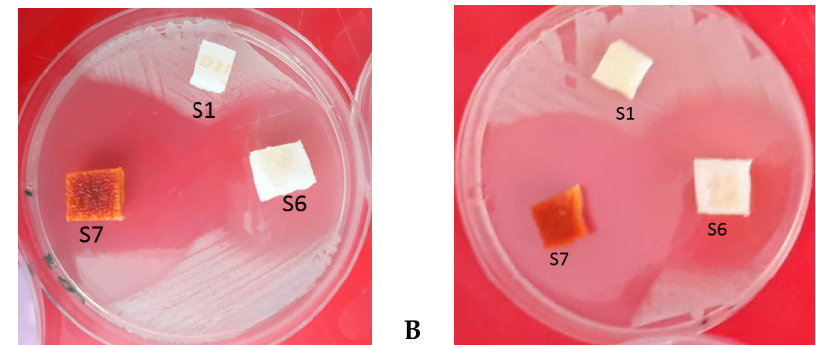
Figure 6. Exemplary photographs showing the antibacterial activity of the tested dressing: S6—modified Br 2 /Cip-Bi hydrogel and S7—modified I 2 /Cip-Bi hydrogel in relation to the untreated dressing (control sample S1) against S. aureus c.i.w ( A ) and E. coli c.i.w ( B ) strains .